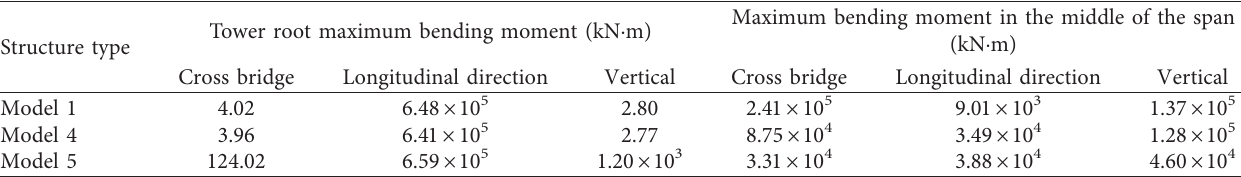
Table 10: The maximum bending moments of the tower roots and midspans of the three structural models under transverse+1/2 vertical excitation.